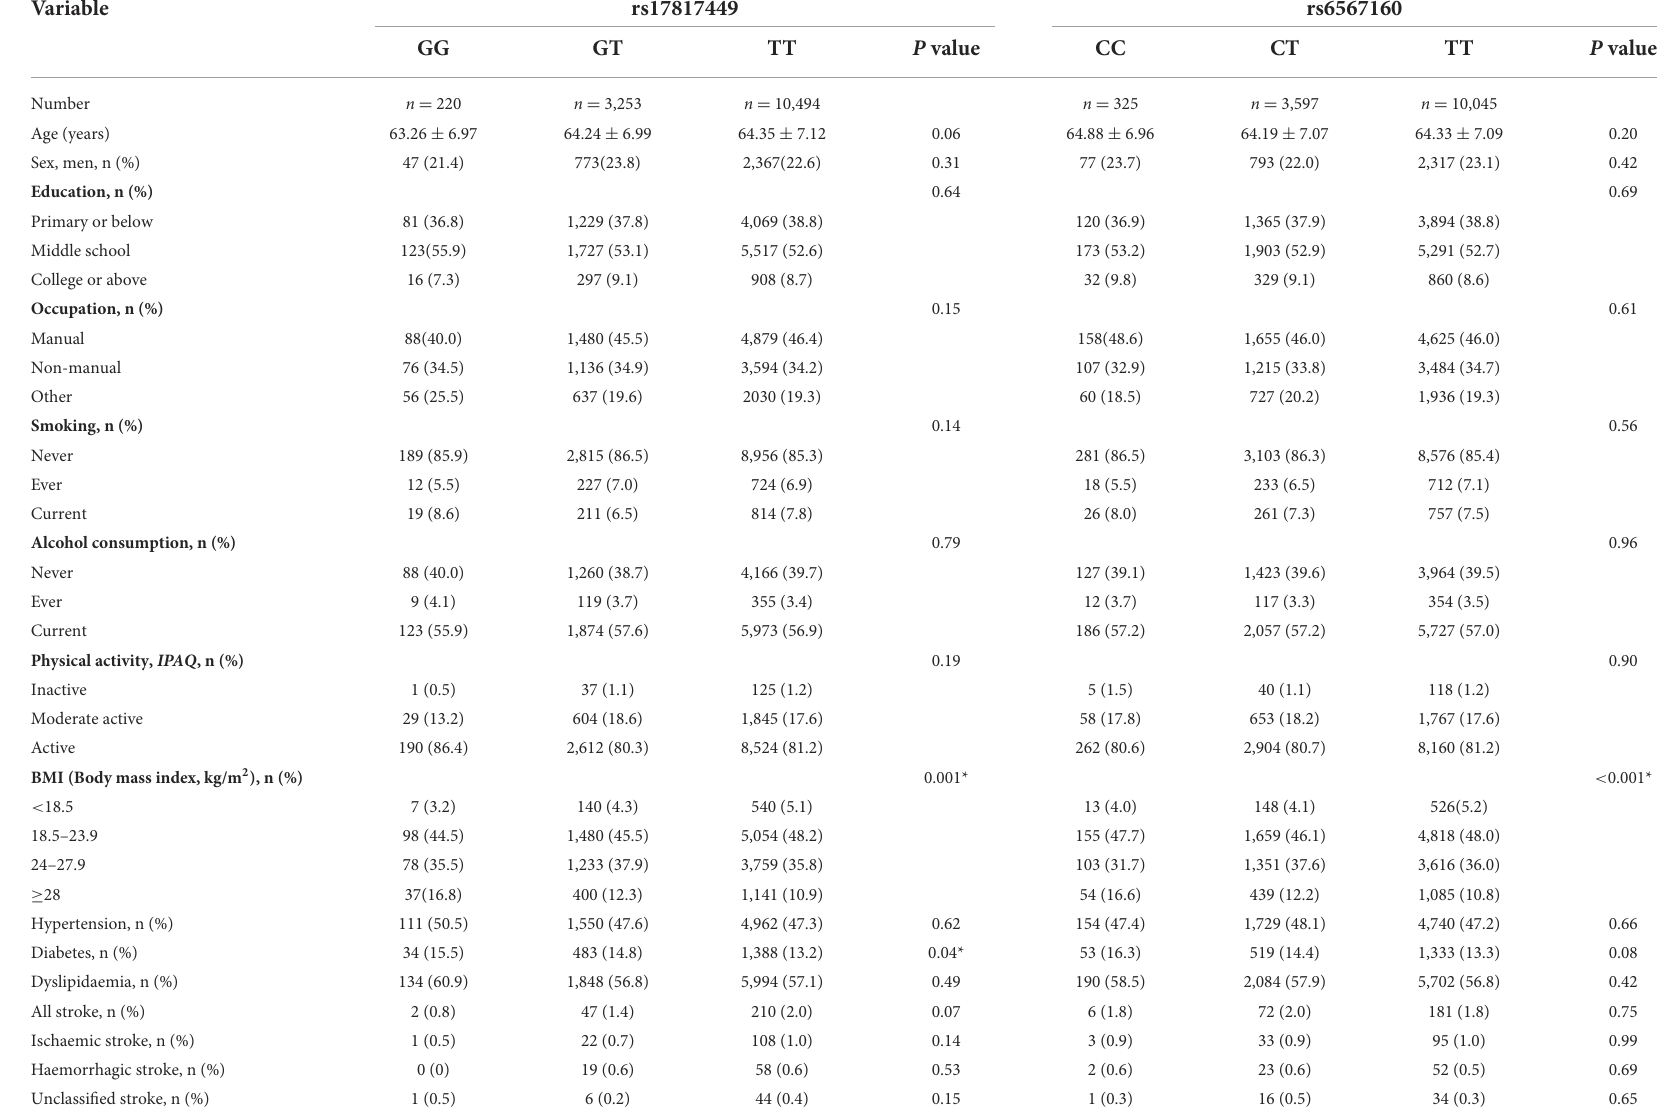
TABLE 5 Baseline characteristic of rs17817449 and rs6567160 ( n = 13,967).